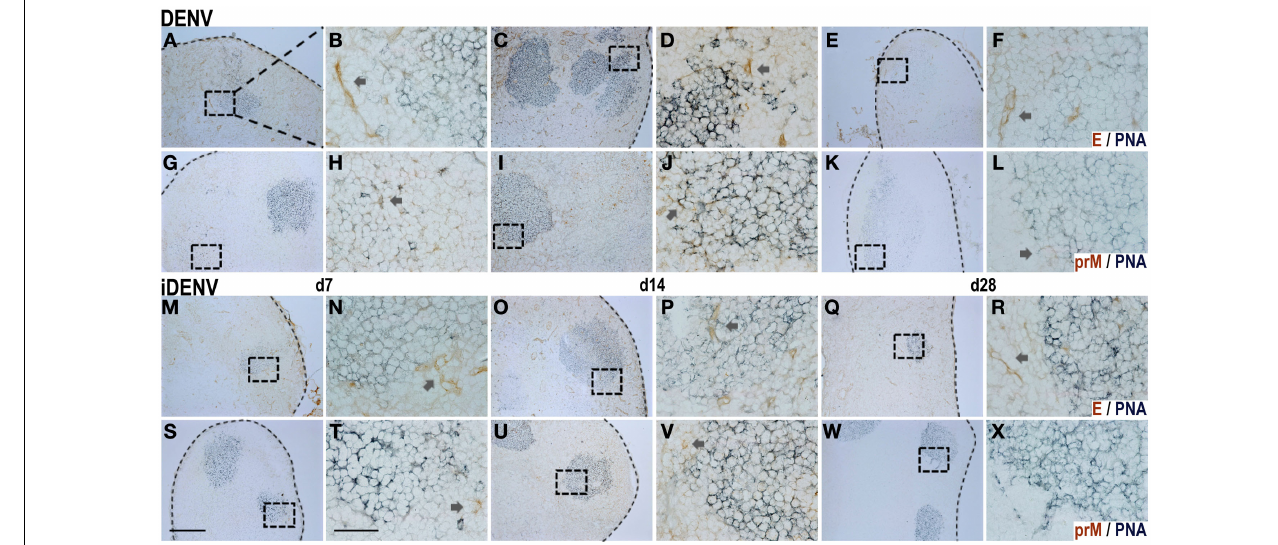
in (H,J,L,T,V) ]. In the case of iDENV, the proteins distribution was scant. At day 28, the intensity of the staining diminished, and prM positive cells were fewer. For each time point, right images (60 × , scale bar 40 µ m, T) correspond to the squares indicated on the left (10 × , scale bar 200 µ m, S). Dotted lines indicate the limits of LNs. Representative pictures from one of three independent experiments are shown. Mice were inoculated at day 0 and boosted at day 7.